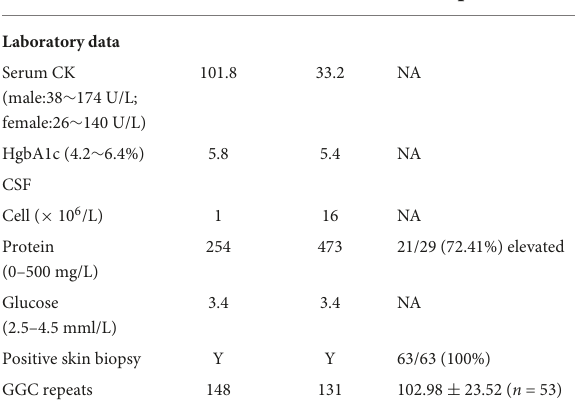
TABLE 1 Summary of clinical features of NIID